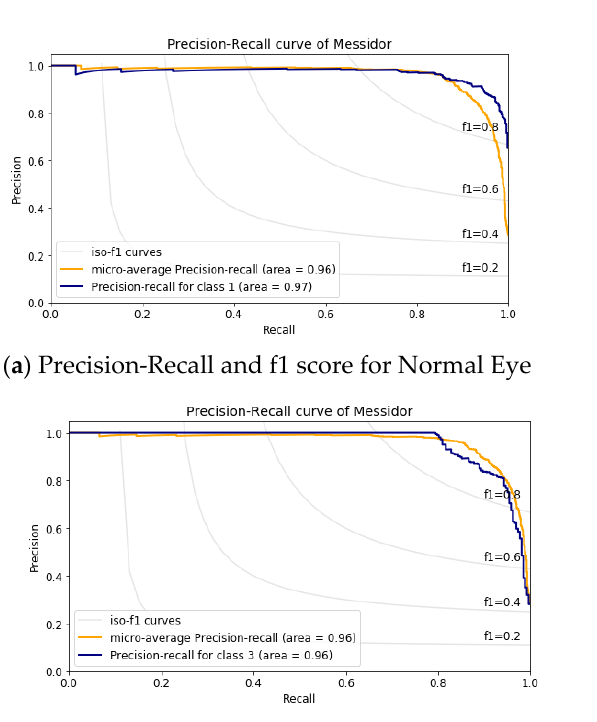
Table 3. Comparison of results of existing methods and the proposed